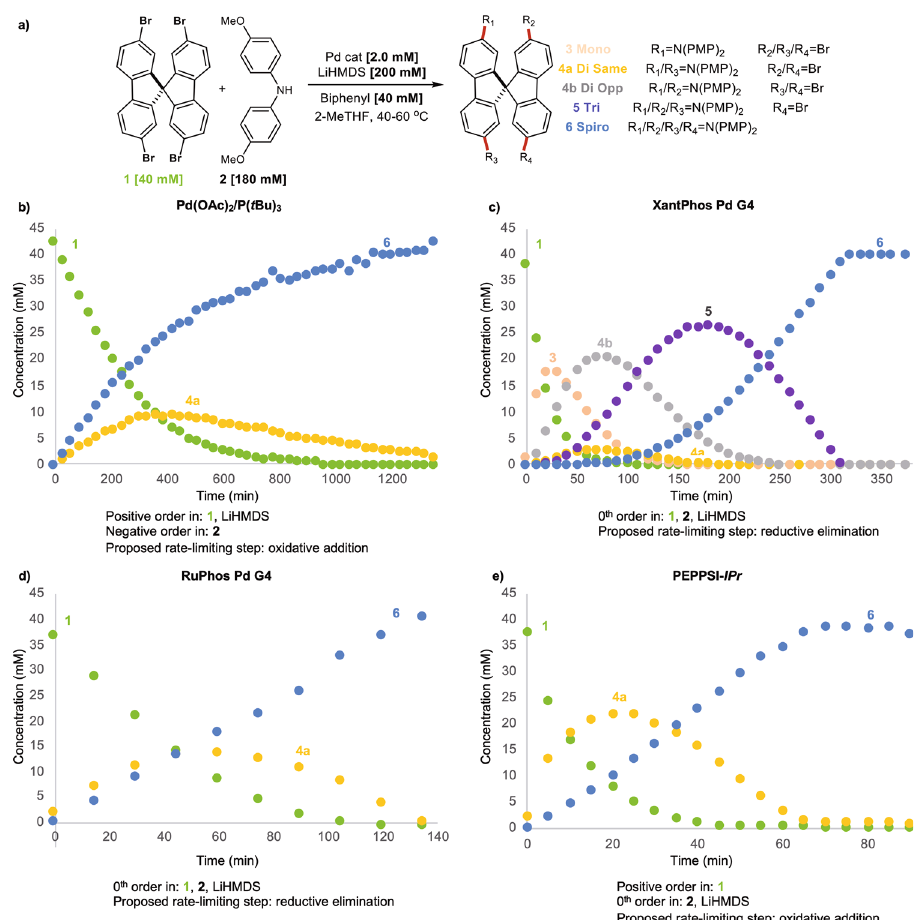
Fig. 4 Standard time course data of targeted catalyst. a Reaction scheme and conditions for standard condition time course reaction pro fi les. b , Standard time course for Pd(OAc) 2 /P( t Bu) 3 and summary of kinetic experiments. c Standard time course for XantPhos Pd G4 and summary of kinetic experiments. d Standard time course for RuPhos Pd G4 and summary of kinetic experiments. e Standard time course for PEPPSI-IPr and summary of kinetic